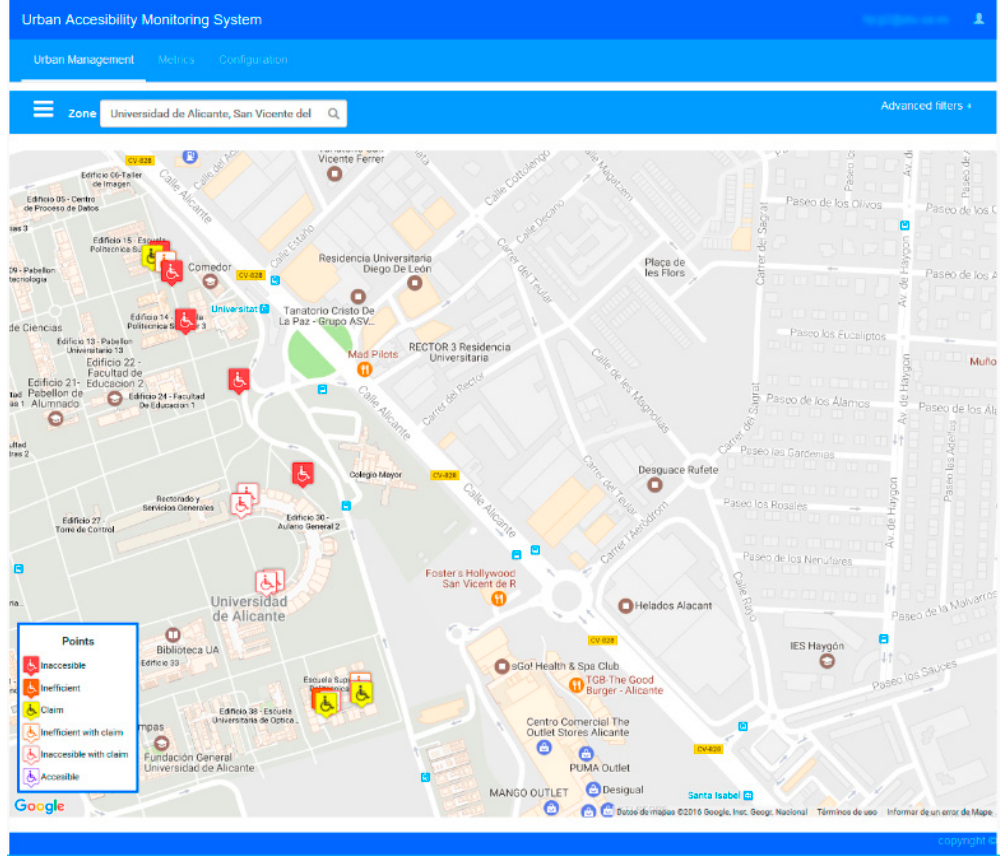
Figure 12. Urban Accessibility Monitoring Service Web Application Screenshot.